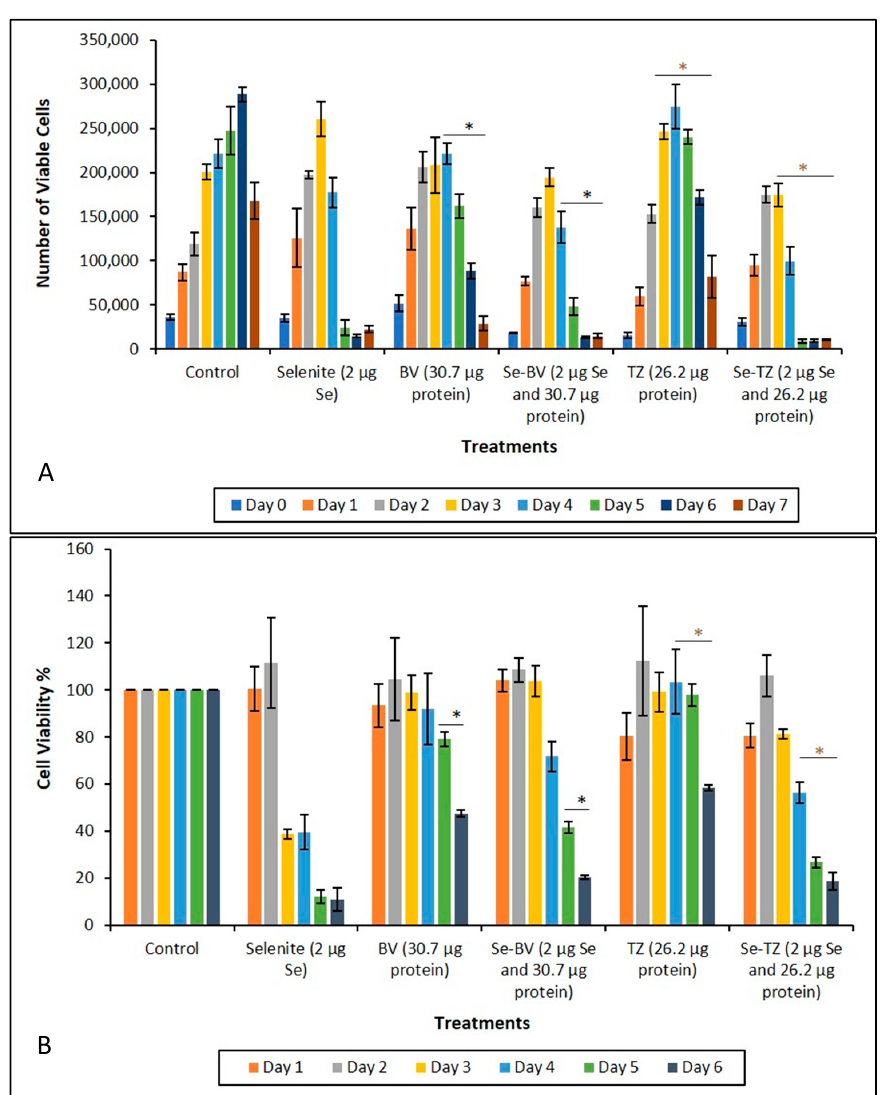
Figure 7. Analysis of cytotoxicity as a function of percent cell viability during treatment. ( A ) Cytotoxic effects of control, selenite, BV, Se-BV, TZ and Se-TZ Treatments against MDA-MB-468 cells. Forty-thousand cells were seeded in 48-well-plates and treated (Day 0 of treatment). Viable cells were counted for 7 days and analyzed by Trypan Blue exclusion. The data is expressed as Means ± SE ( n = 3). Statistical treatments were compared using two sample t -tests. Treatments were considered statistically significant if p ≤ 0.05 and indicated by * (brown color). ( B ) Growth inhibition of control, selenite, BV, Se-BV, TZ, or Se-TZ treated MDA-MB-468 cells as determined by MTT assay over 6 days. Forty-thousand cells were seeded in 48-well-plates and treated (Day 0 of treatment). The data is expressed as the Means ± SE ( n = 3). Treatments were compared using two sample t -tests. Treatments were considered statistically significant if p ≤ 0.05 (represented by * (black color)). Asterisks indicate significant differences between TZ and Se-TZ ( A ) and BV and Se-BV ( B ).